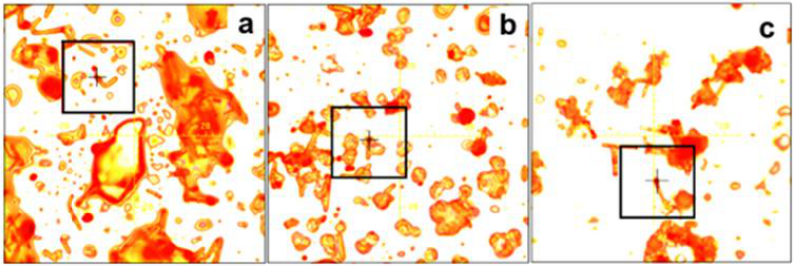
Figure 3. Micrographs of samples of the SERS-active substrate of Au@Ni nanotubes with analytes (NO 2)3 C 6 H 2 N(NO 2 )CH 3 at various concentrations: ( a ) − 10 − 2 M, ( b ) − 10 − 3 M, ( c ) − 10 − 4 M. The